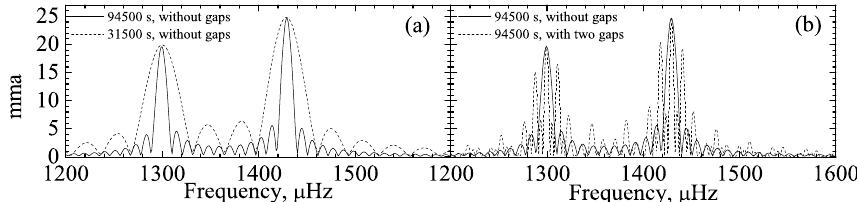
Fig. 1. Fourier power spectra of the three simulated photometric data runs. The solid lines in both panels correspond to the simulated light curve covering 94500 s time span without gaps. The dashed line in panel (a) corresponds to the simulated light curve covering 31500 s time span without gaps, while that in panel (b) corresponds to the simulated light curve covering 94500 s with two gaps between different